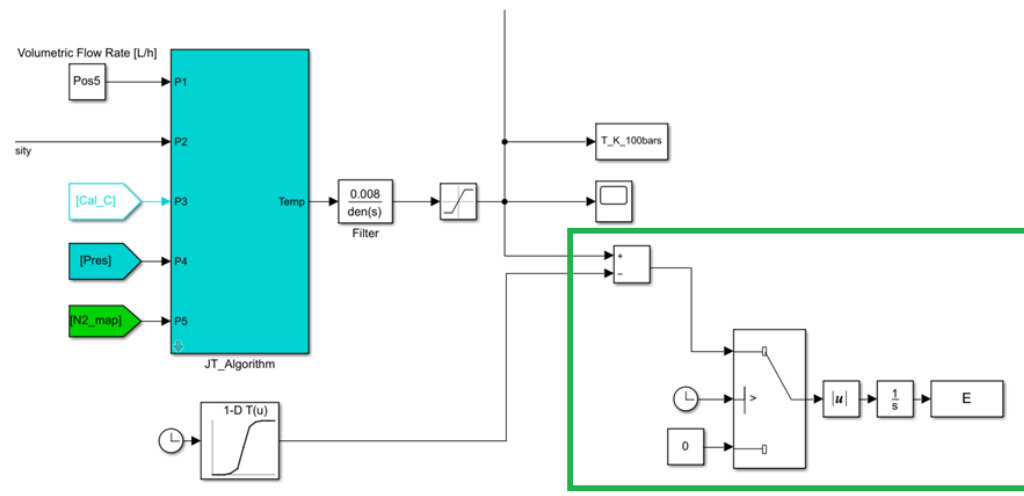
Figure 16. Optimization criteria.